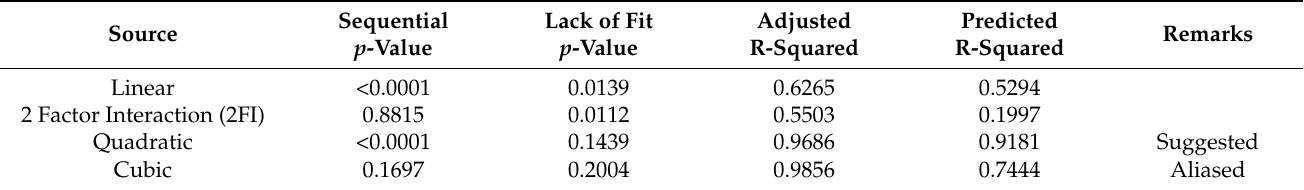
Table 5. Fit summary table for response, phenolic yield.